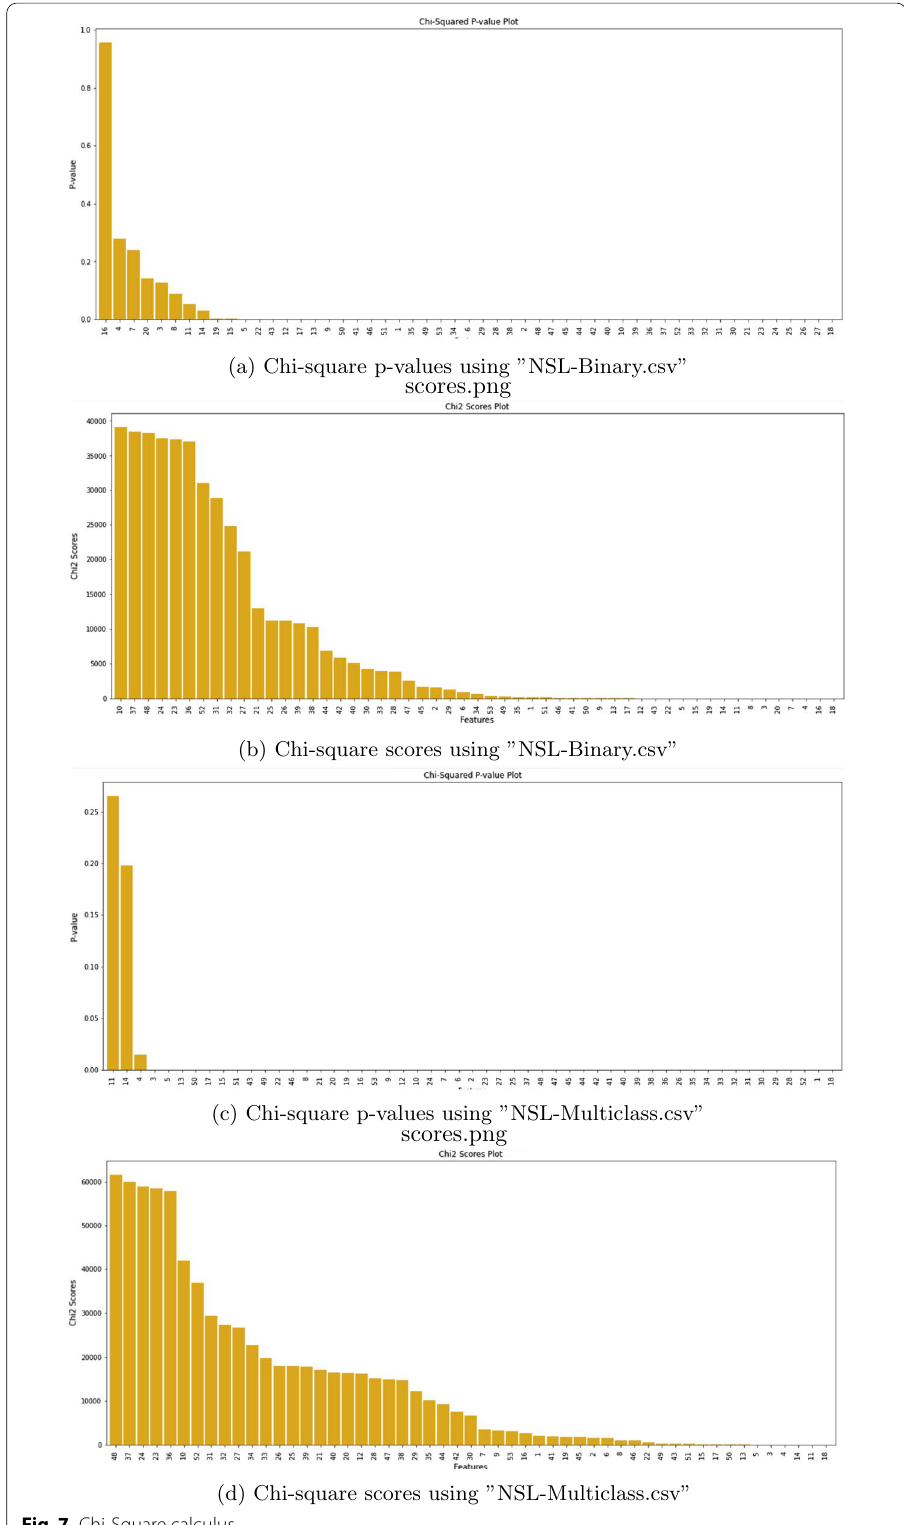
Fig. 7 Chi-Square